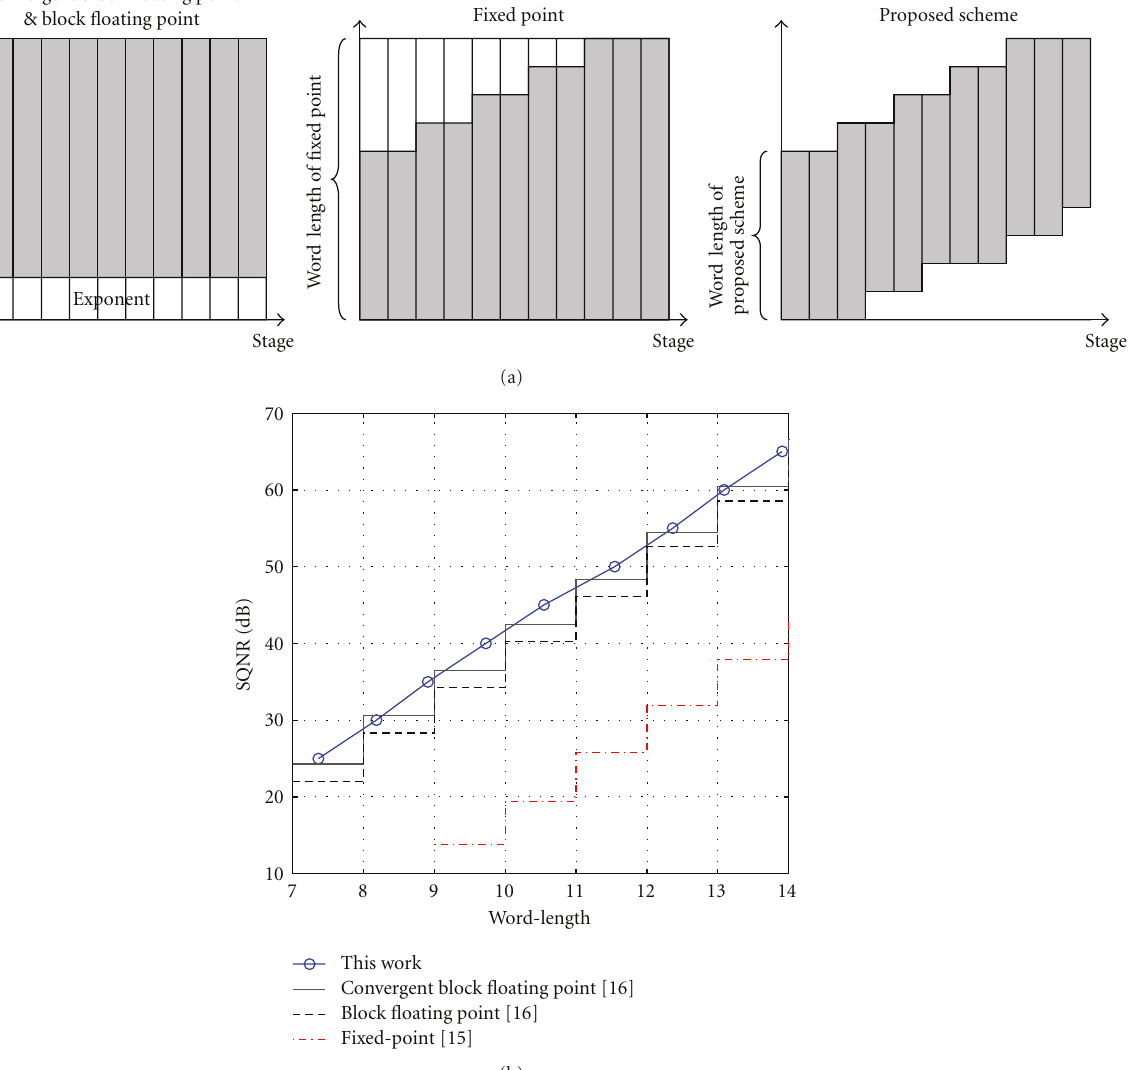
Figure 10: (a)Illustration of di ff erent data-path representations and (b) comparisonof SQNR values versus word-length settings by di ff erent